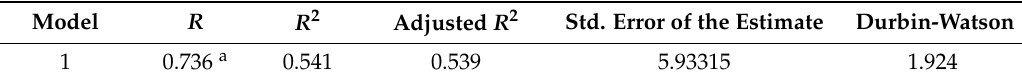
Table 5 represents the summary of the regression model: Table 5. Model Summary b .